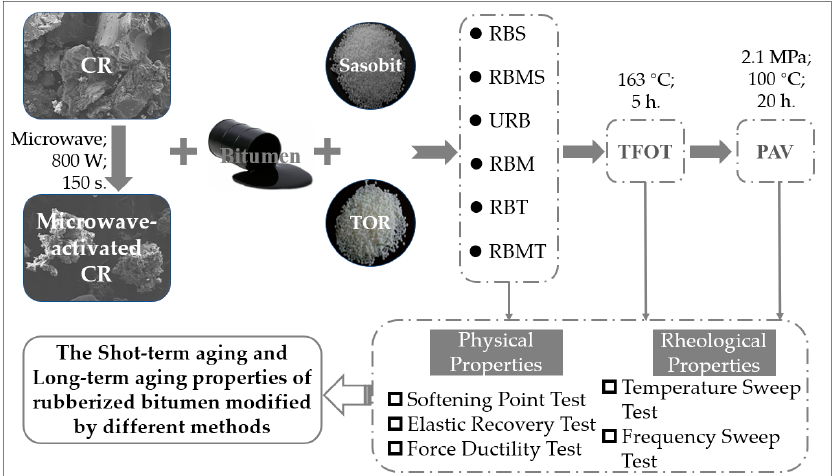
Figure 1. Flowchart of research steps in this study.